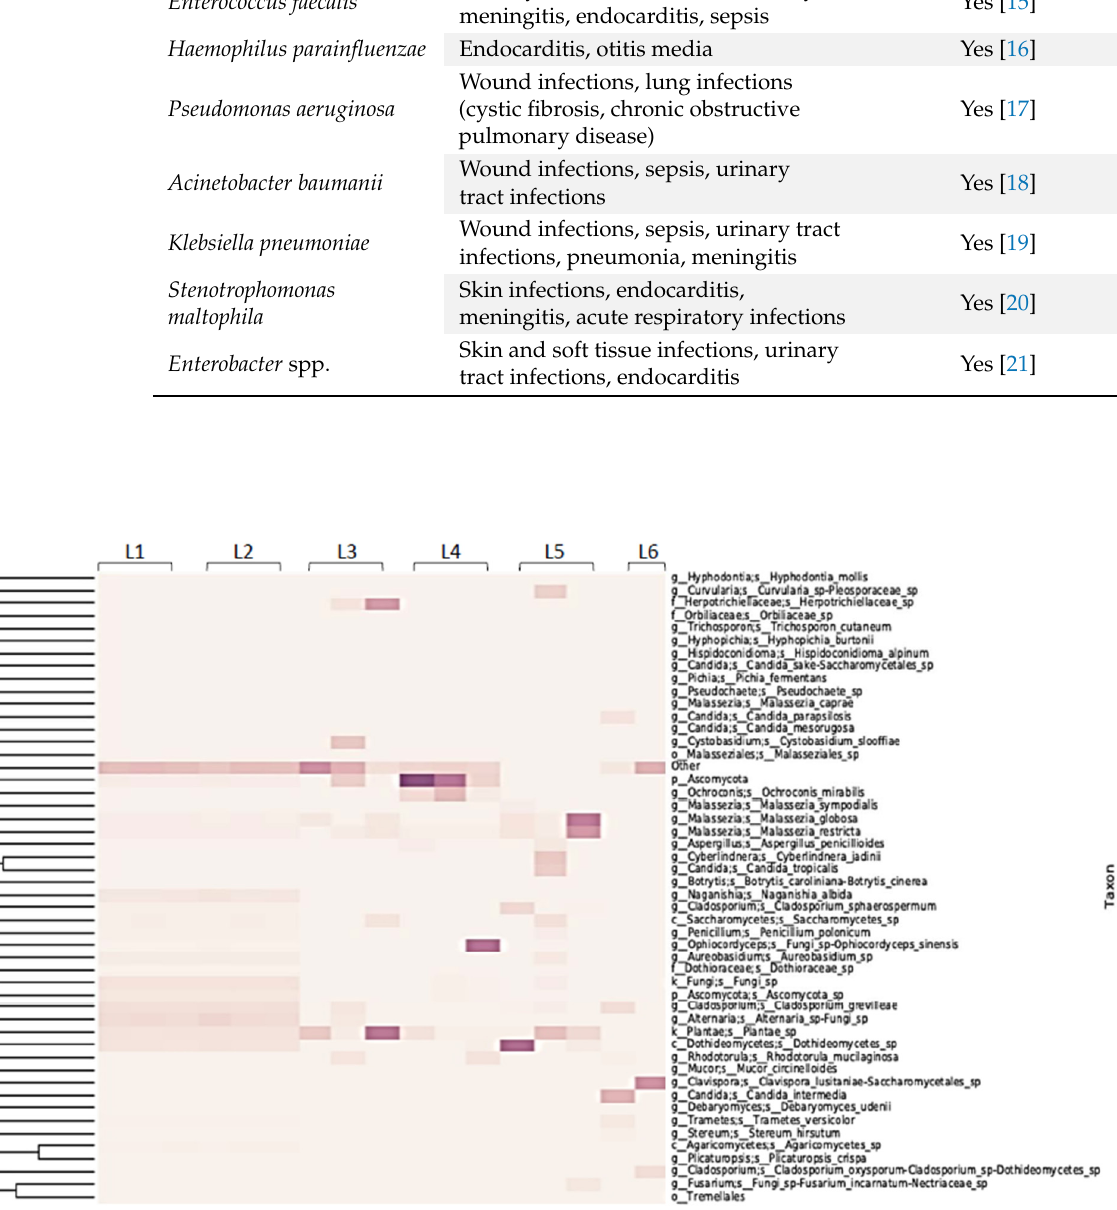
Figure 5. Heat map of fungal identifications from sentinel washcloths (one per washing machine) laundered in public washing machines.